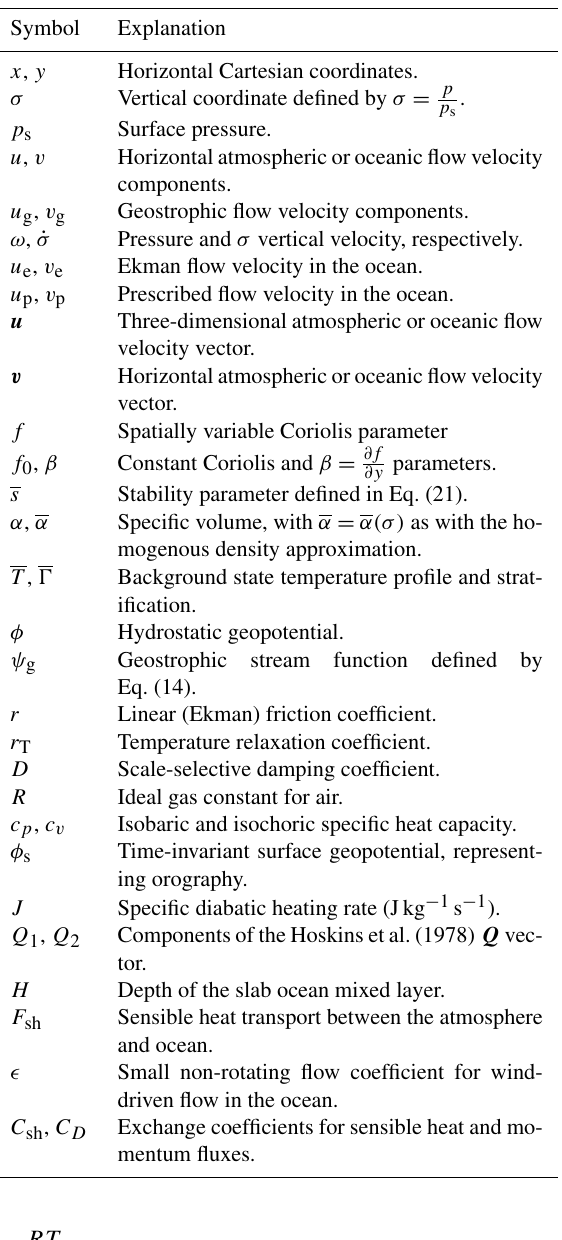
Table 2. List of symbols. Where ambiguous, superscripts “a” or “o” denote atmospheric or oceanic variables,